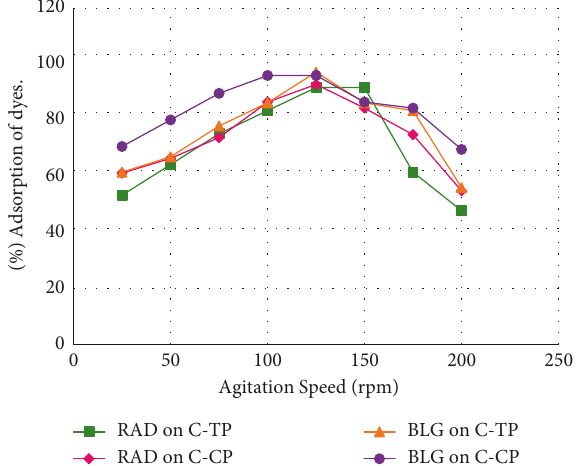
Figure 11: Effect of agitation speed on adsorption. Initial pH � 5, final pH for RAD on C-TP � 4, RAD on C-CP � 4.5, BLG on C- TP � 4.5, and BLG on C-CP � 4.